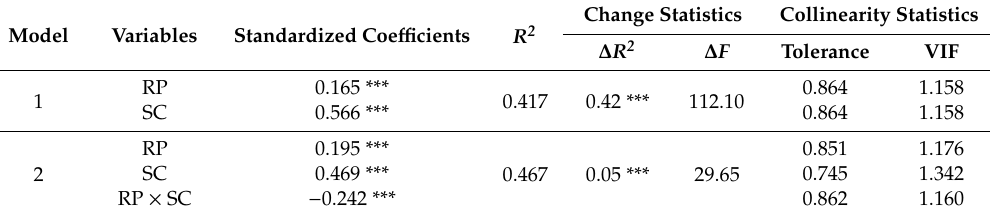
Table 8. Moderated regression analyses of